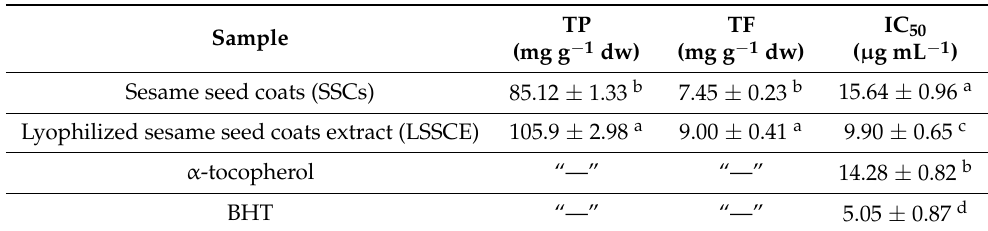
Table 2. Total phenolic (TP) and total flavonoid (TF) contents and radical scavenging activity of lyophilized sesame seed coats extract